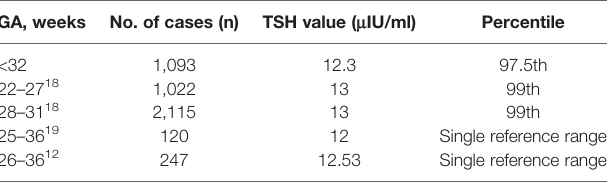
TABLE 4 | TSH reference ranges of preterm infants at PMA 36 weeks in previous studies. GA, weeks No. of cases (n) TSH value ( m